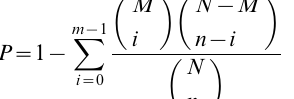
Table S1 SNPs and the blastx results of genes related to GABA receptor and sodium channel.